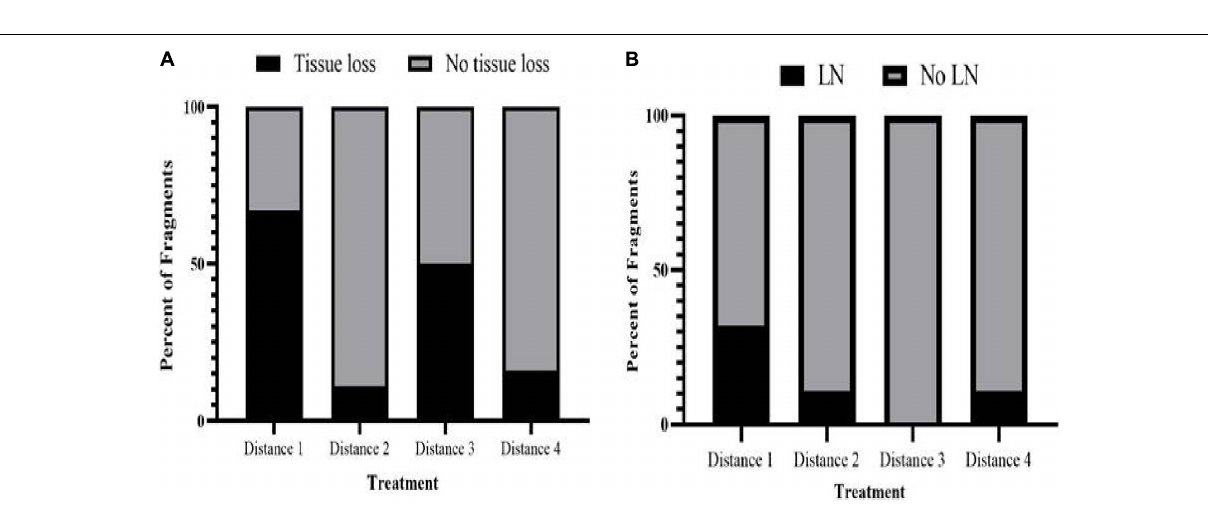
Frontiers in Marine Science |